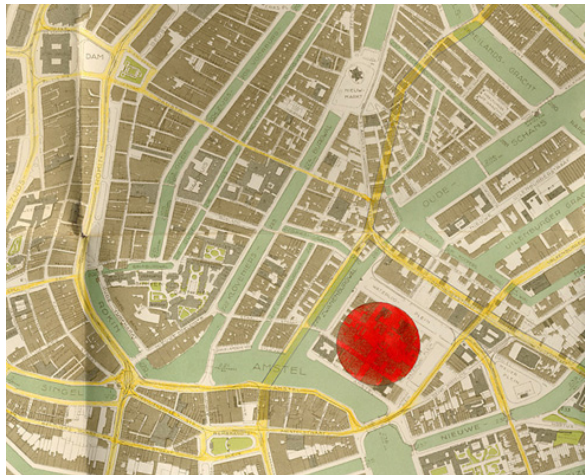
Figure 1. Site for new city hall published in Program of Requirements,